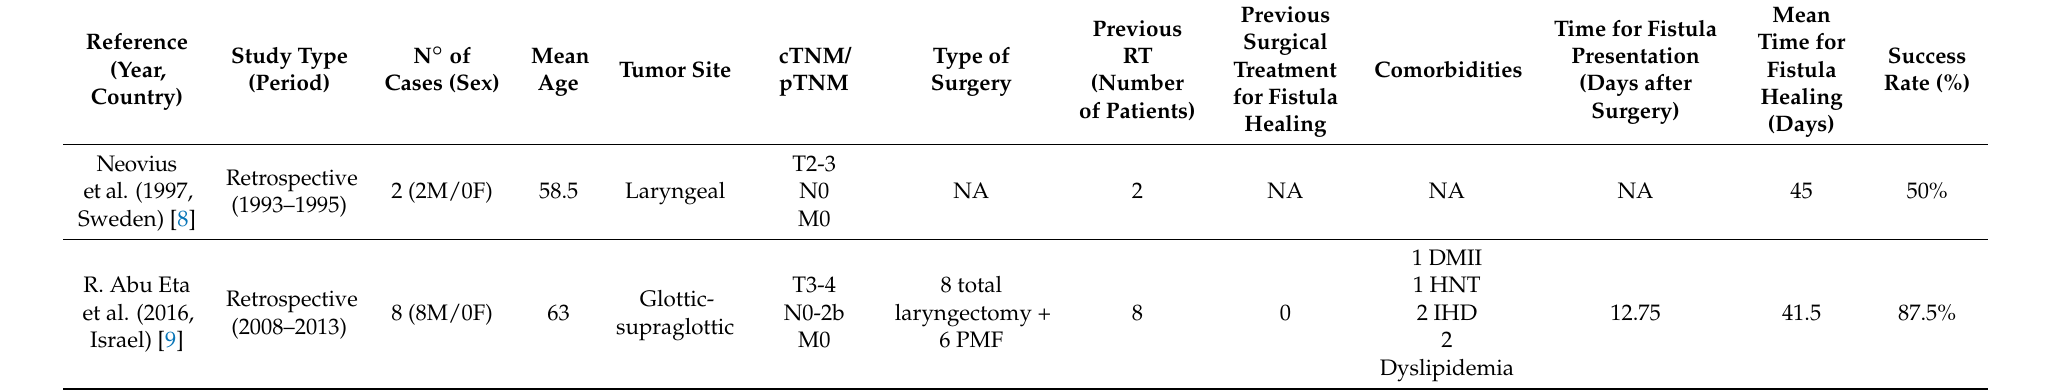
Table 1. Overview of the clinical outcomes of patients treated for PCF using hyperbaric oxygen therapy (HBOT). Acronyms: NA, not available; M, male; F,